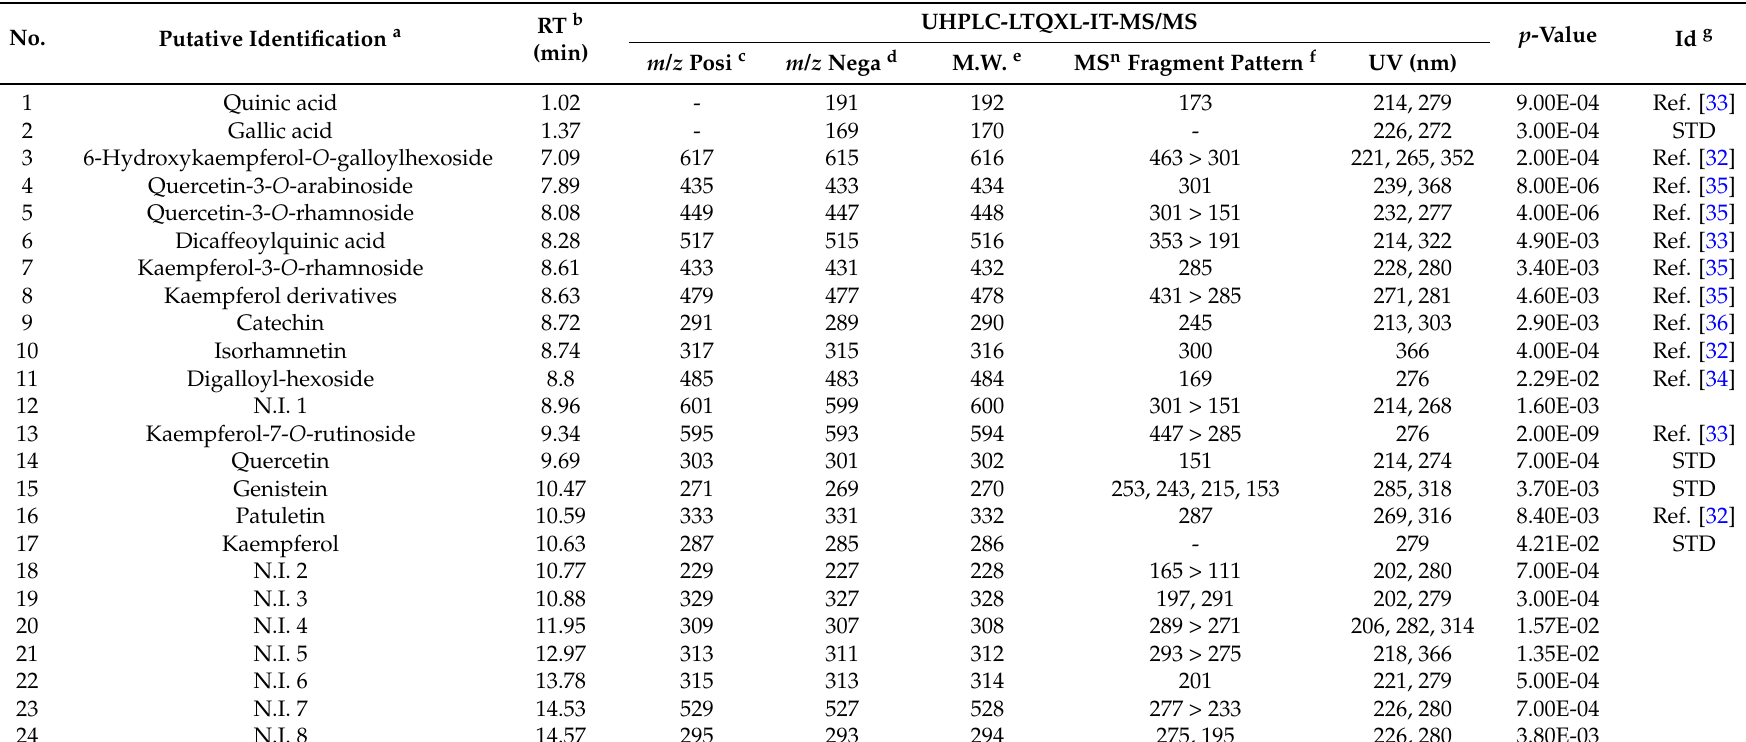
Table 1. Tentatively identified metabolites in 6 plant families that contributed to family clusters by